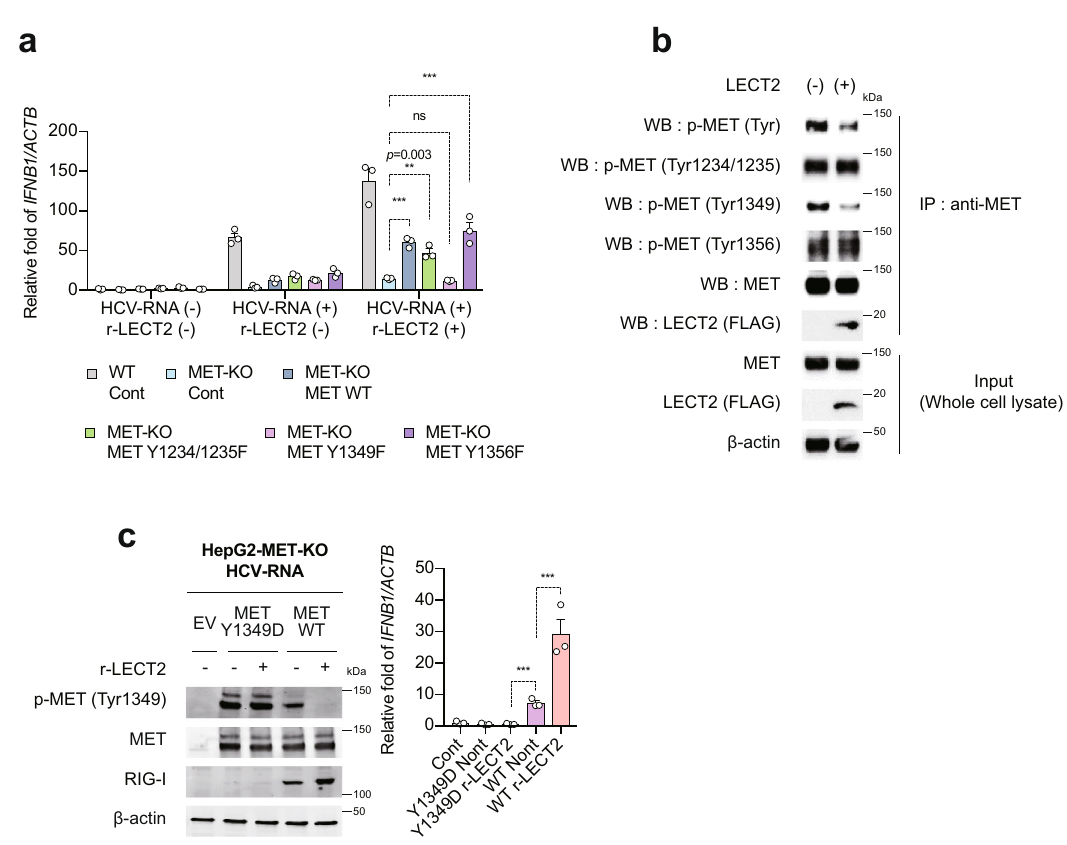
Fig. 5 LECT2 activates innate immune responses by suppressing Tyr1349 phosphorylation in MET. a HepG2-MET-KO cells were transfected with Control plasmid (Cont), MET WT plasmid (MET WT), or MET mutant plasmid (MET Y1234/1235F, MET Y1349F or MET Y1356F). At 24 h after transfection, the cells were treated with 50 ng/mL r-LECT2 for 1 h and then transfected with HCV-RNA (H77S.3/GLuc-RNA). As a control, HepG2-WT cells were transfected with Cont plasmid; at 24 h after transfection, the Cont plasmid-transfected HepG2-WT cells were treated with 50 ng/mL r-LECT2 for 1 h and then transfected with HCV-RNA. qRT-PCR analysis of IFNB1 in these cells as described above at 12 h after HCV-RNA transfection. Results were normalised to those of ACTB . Data shown are means of 3 technical replicates± SEM. *** p < 0.001, ** p = 0.003, not signi fi cant (ns) by two-way ANOVA with Tukey ’ s multiple comparison test. b HepG2 cells were transfected with Control plasmid (LECT2 ( − )) or FLAG-tagged LECT2 plasmid (LECT2 ( + )). At 48 h after transfection, lysates were immunoprecipitated with an anti-MET antibody. Immunoblot analysis of p-MET (Tyr), p-MET (Tyr1234/1235), p-MET (Tyr1349), p-MET (Tyr1356), MET, LECT2 (FLAG) and β -actin in immunoprecipitated samples and input cell lysate. c HepG2-MET-KO cells were transfected with Control plasmid (EV), MET Y1349D plasmid, or MET WT plasmid. At 24 h after transfection, the cells were treated with 50 ng/mL r-LECT2 for 1 h and then transfected with HCV-RNA (H77S.3/GLuc-RNA). c (left) Immunoblot analysis of p-MET (Tyr1349), MET, RIG-I and β -actin at 12 h after HCV-RNA transfection. c (right) qRT-PCR analysis of IFNB1 in these cells as described above at 12 h after HCV-RNA transfection. Results were normalised to those of ACTB . Data shown are means of 3 technical replicates ± SEM. *** p < 0.001 by two-way ANOVA with Tukey ’ s multiple comparison test. Source data are provided as a Source data fi